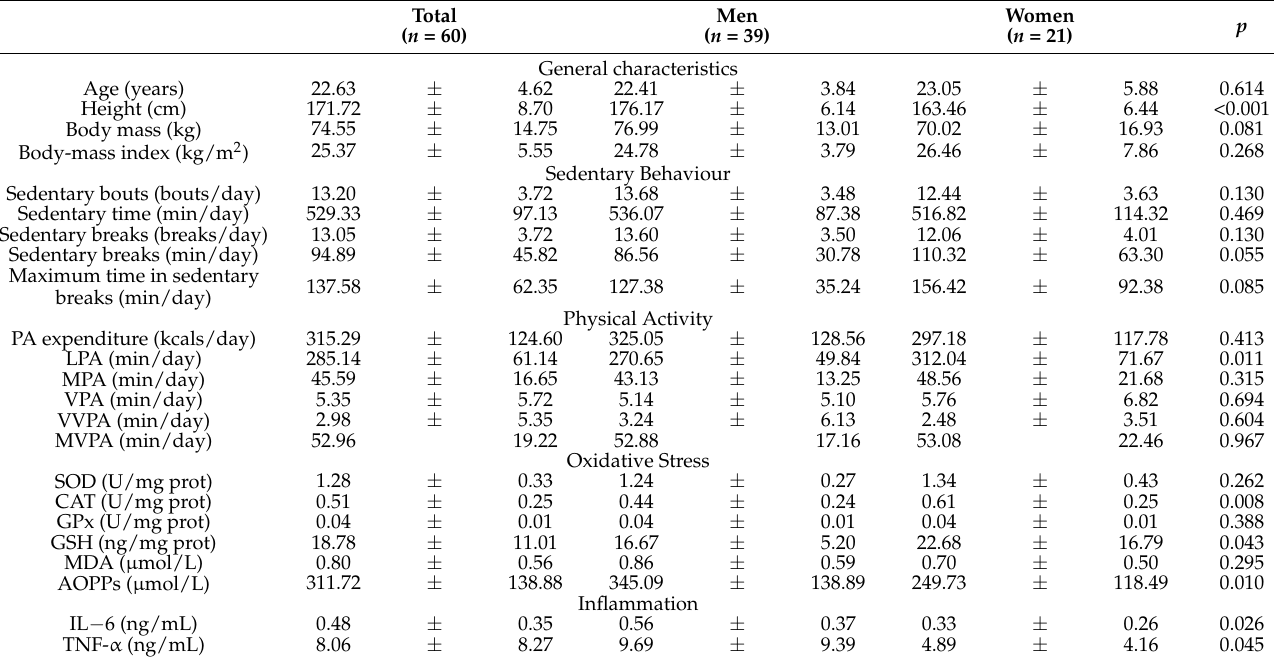
Table 1. Participant characteristics by